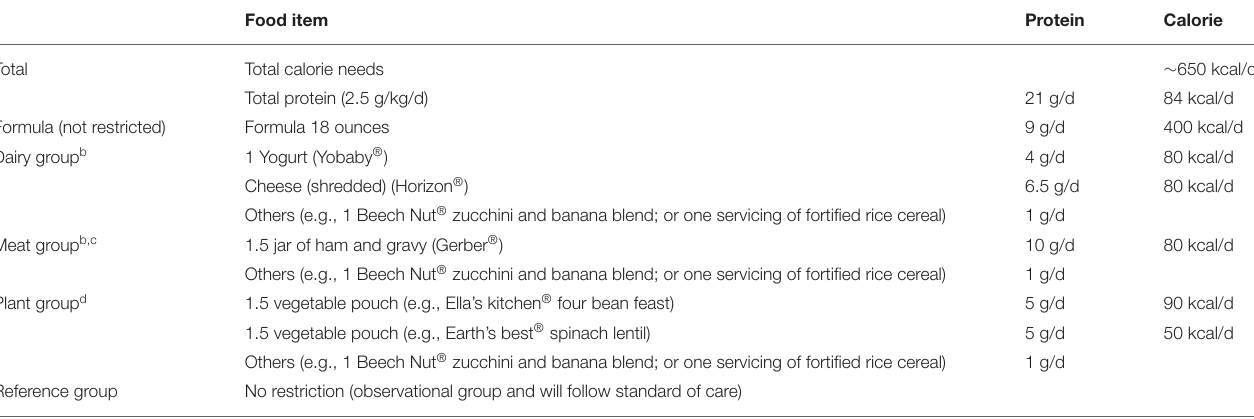
TABLE 1 | Examples of diet plans for the three intervention groups a . Food item